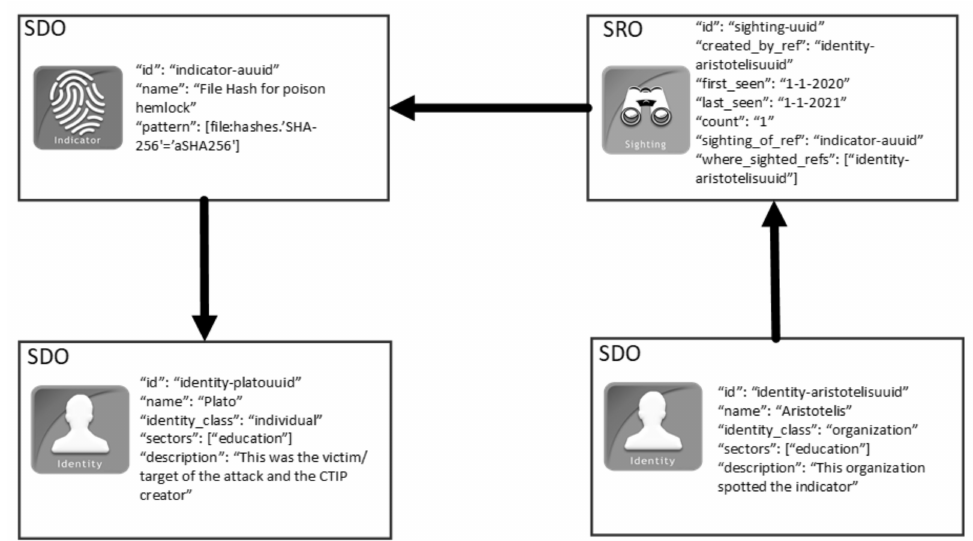
Figure 2. An illustrative example of a Sighting STIX Relationship